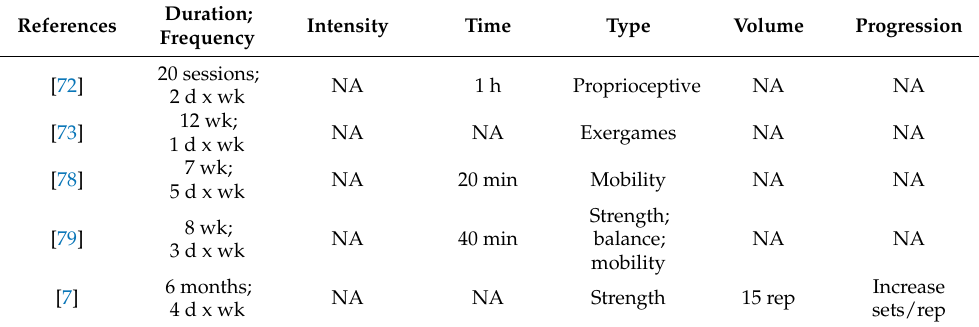
Table 5. The principles of exercise prescription during COVID-19.